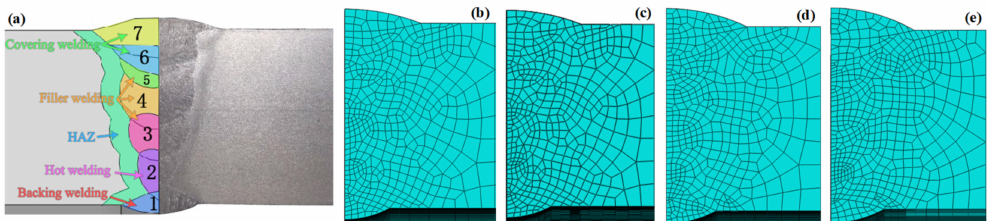
Figure 2. Geometric model of pipeline joint: ( a ) weld bead division, meshed model of ( b ) 0 mm, ( c ) 1 mm, ( d ) 2 mm, ( e ) 3 mm.